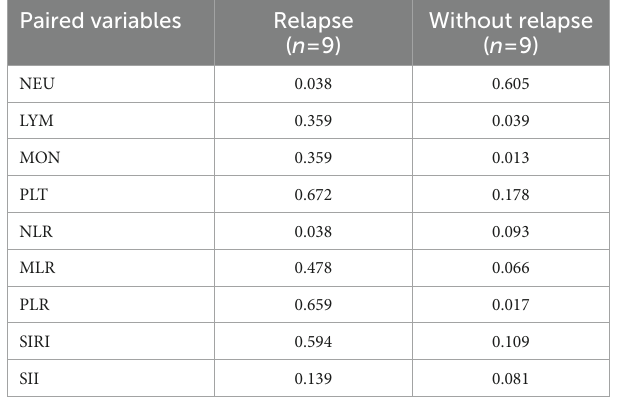
TABLE 6 Comparison of pre- and post-treatment indicators between NMOSD patients with and without relapse. Paired